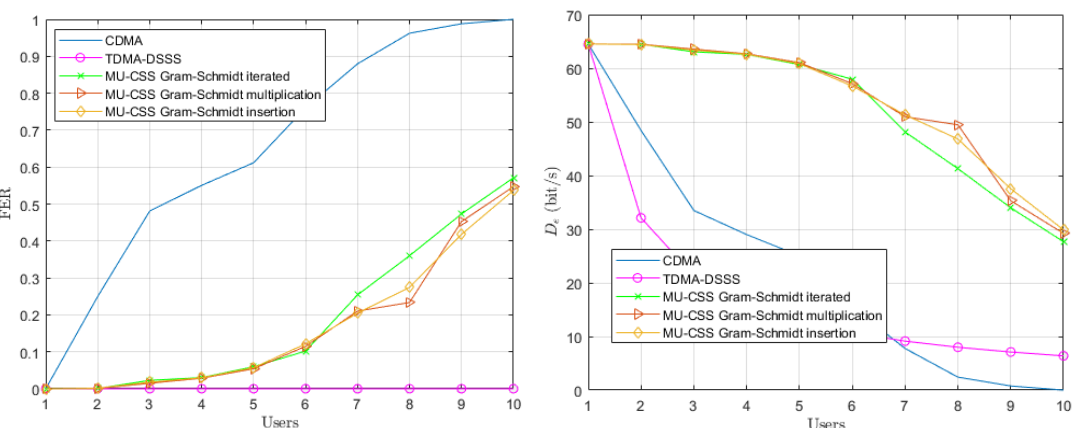
Figure 7. Average FER performance ( left ) and effective data rate ( right ) versus number of users over the time-varying simulated UWA channel model with static